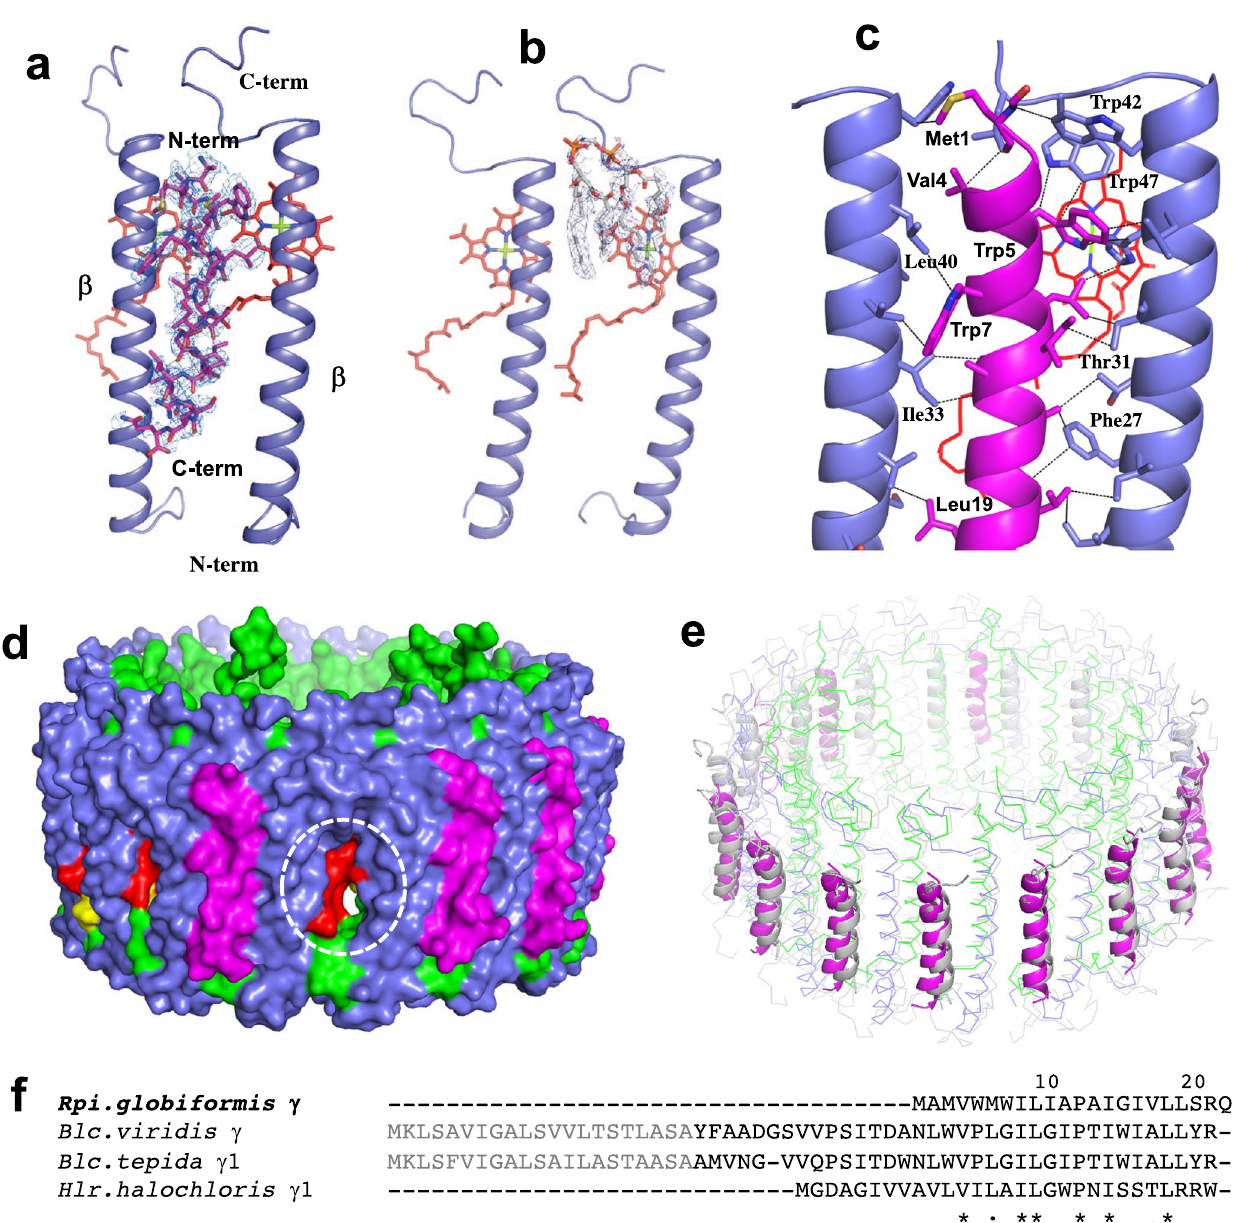
Fig. 5 Structure of the γ -like polypeptides in the Rpi. globiformis LH1. a Density map of a typical γ -like polypeptide with its nearby LH1 β -polypeptides showing the opposite orientations. The density map is shown at a contour level of 4.0 σ . b Density map of a cardiolipin with its nearby LH1 β - polypeptides at the location that lacks a γ -like polypeptide. c Interactions between a γ -like polypeptide (magenta) with its neighboring LH1 β - polypeptides (slate blue) with the dashed lines representing typical close contacts (<4.0 Å) between the two polypeptides. A BChl a molecule is shown by red sticks. d Side view of a surface representation showing a channel (white dashed circle) in the LH1 ring which lacks a γ -like polypeptide, other channels are sealed by the γ -like polypeptides (magenta). Color scheme: LH1- α , green; LH1- β , slate blue; BChl a , red; carotenoids, yellow. e Superposition of the LH1 polypeptides between Rpi . globiformis (colored) and Blc. viridis (PDB: 6ET5, gray) showing the structural similarity between the γ -polypeptides (cartoon). f Alignment of the γ -polypeptides between Rpi . globiformis and BChl b -containing species with identical amino acids (*), conservative (:) and semi-conservative (.). The N-terminal fragments in Blastochloris species shown by gray fonts were not identi fi ed in the puri fi ed protein. Hlr : Halorhodospira